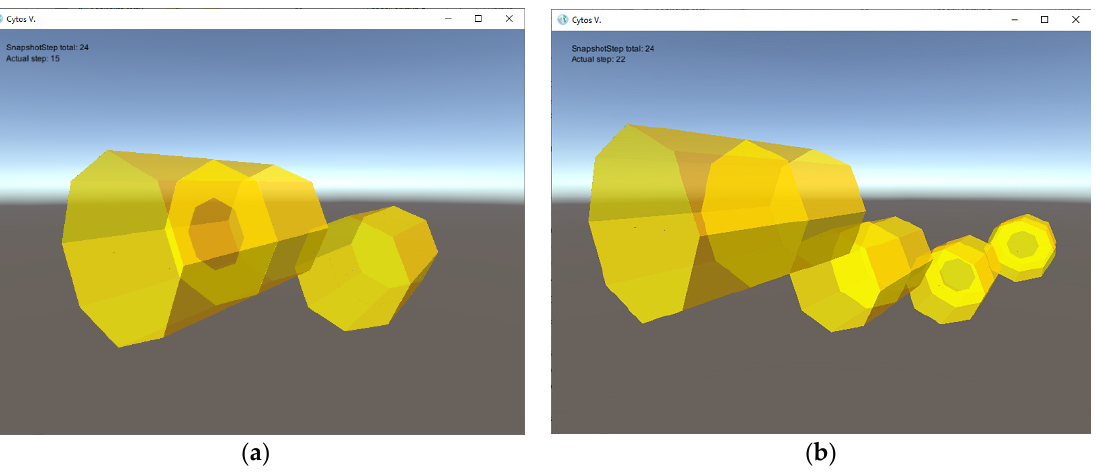
Figure 2. Snapshot of the M system M bac modeling bacterial growth processes with cell division occurring through septum formation (with octagonal tiles). The large octagon in ( a ) has completed its growth in ( b